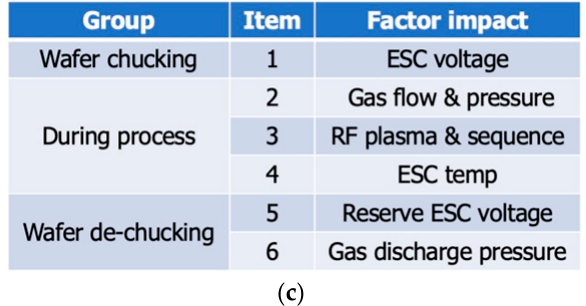
Figure 4. Experimental process flow for powder spray positioning and process control factor design. ( a ) Powder collection from deposition by-products inside the turbopump exhaust line. ( b ) Experi- mental process flow for the spraying of powder separately on the (1) top electrode, (2) edge ring, (3) chamber wall, (4) exhaust plate. Wafer process check flow was performed under wafer transfer only, N2 flow rate of 200sccm, Top RF power 500 W, and ESC voltage of 2500 V. ( c ) Verification of the process parameters affecting the experimental flow in the chamber for more than 200 RF hours.